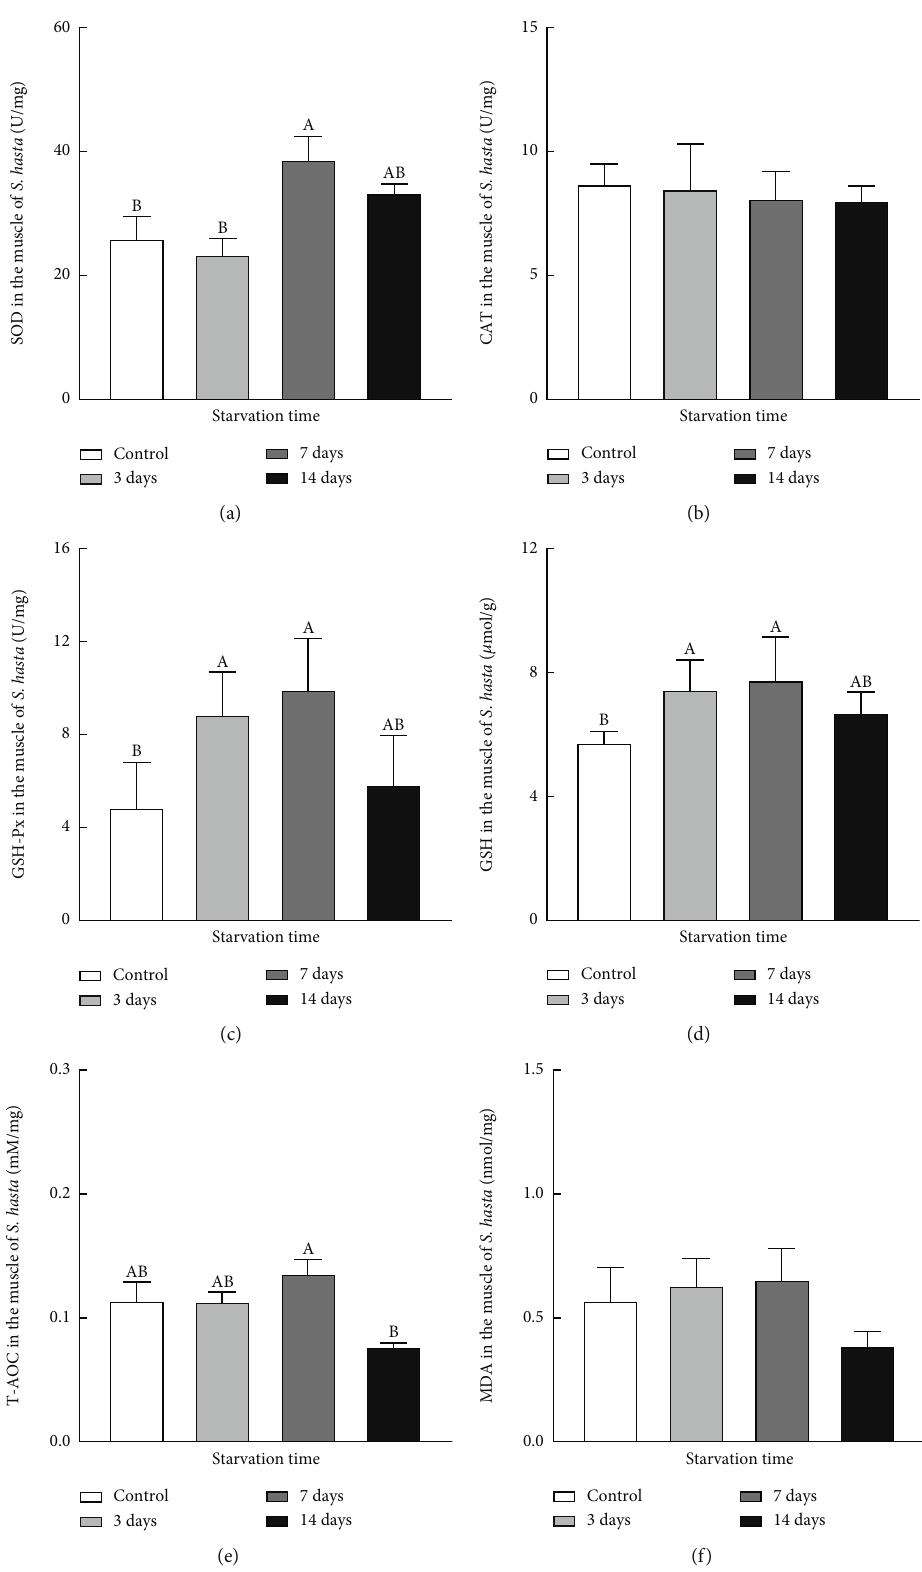
Figure 2: E ff ects of starvation on the muscular antioxidant capacity of Synechogobius hasta. Changes in SOD (a), CAT (b), GSH-Px (c), GSH (d), T-AOC (e), and MDA (f) in the muscle of S. hasta subjected to di ff erent starvation periods. Antioxidant index values were represented as means ± SD ( n = 5 ) and evaluated using one-way ANOVA. Di ff erent uppercase letters denote signi fi cant di ff erences ( P < 0 : 05